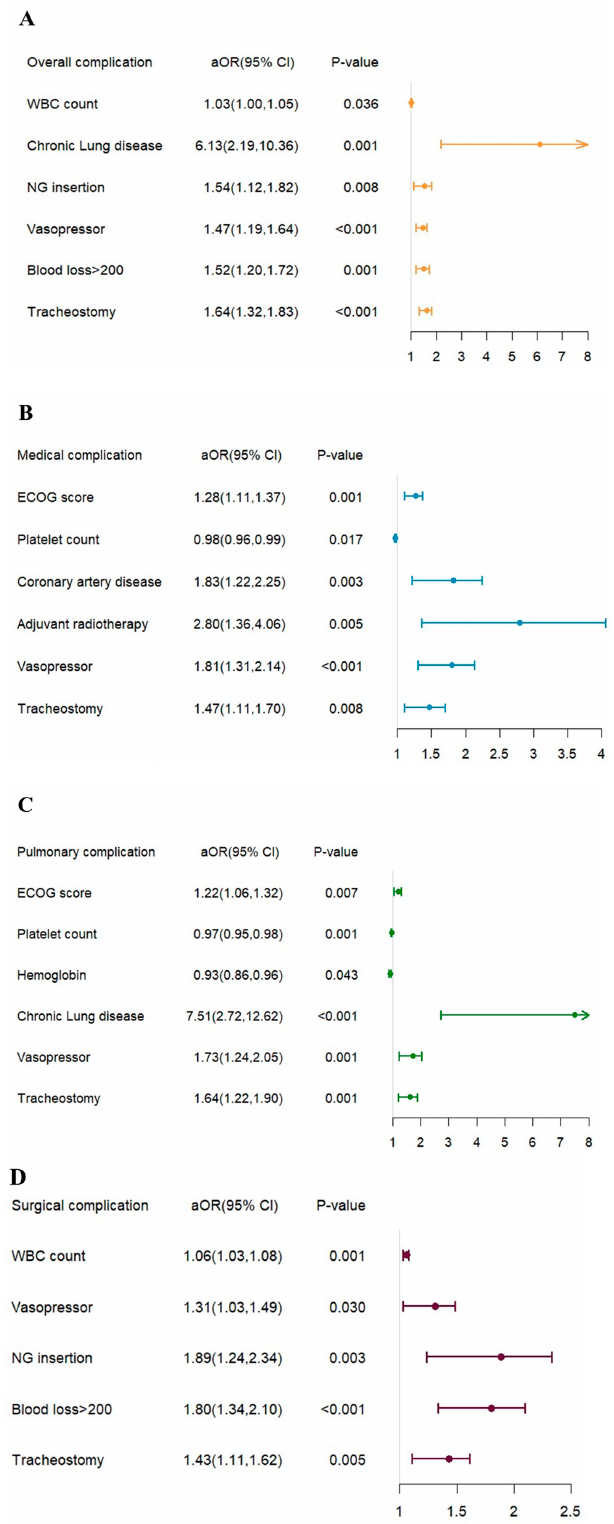
Figure 3. The significant risk factor for ( A ) overall complication, ( B ) medical complication, ( C ) pul- monary complication, and ( D ) surgical complication. Higher ECOG score (OR = 1.28, [95% CI] = 1.11–1.37; p -value = 0.001), comorbidity with coronary artery disease (OR = 1.83, [95% CI] = 1.22–2.25; p -value = 0.003), the patients who received adjuvant radiotherapy (OR = 2.80, [95% CI] = 1.36–4.06; p -value = 0.005), the patients who ever received vasopressors (OR = 1.81, [95% CI] = 1.31–2.14; p -value < 0.001) and the patients who received tracheostomy during surgery (OR =1.47, [95% CI] = 1.11– 1.70; p -value = 0.008) were shown to have a higher risk for medical complications. Higher pre-operative PLT levels (OR =0.98, [95% CI] = 0.96–0.99; p -value = 0.017) had a lower risk of medical complications. Higher ECOG scores (OR = 1.22, [95% CI] = 1.06–1.32; p -value = 0.007), comorbidity with chronic lung disease (OR = 7.51, [95% CI] = 2.72–12.62; p -value < 0.001), patients who ever received vasopressors (OR = 1.73, [95% CI] = 1.24–2.05; p -value = 0.001) and the patients who received tracheostomy during surgery (OR =1.64, [95% CI] = 1.22–1.90; p -value = 0.001) were shown to have higher risk for pulmonary complications. Higher pre-operative Hb lev- els (OR = 0.93, [95% CI] = 0.86–0.96; p -value = 0.043) and PLT levels (OR = 0.97, [95% CI] = 0.95–0.98; p -value = 0.001) were shown to have a lower risk of pulmonary complications. Higher WBC counts (OR = 1.06, [95% CI] = 1.03–1.08; p -value = 0.001), patients who received vasopressors (OR = 1.31, [95% CI] = 1.03–1.49; p -value = 0.030), patients who re- ceived intra-operative NG insertion (OR =1.89, [95% CI] = 1.24–2.34; p -value = 0.003), the patients who had the amount of blood loss >200 c.c during surgery (OR =1.80, [95% CI] = 1.34–2.10; p -value < 0.001) and the patients who received tracheostomy during surgery (OR =1.43, [95% CI] = 1.11–1.62; p -value = 0.005) were shown to have higher risk for surgical com- plication. 3.3. Long-Term Outcome In the results of a Kaplan-Meier analysis, lower PNI was found to have lower overall survival compared with high PNI ( p < 0.001) (Figure 4B). The Cox’s proportional hazard models showed that the high PNI group had lower mortality risk in the unadjusted model (hazard ratio = 0.46, [95% CI] = 0.40–0.52, p -value < 0.001), multivariate model (hazard ratio = 0.73, [95% CI] = 0.63–0.85, p -value < 0.001), and propensity score matching model (hazard ratio = 0.79, [95% CI] = 0.66–0.94, p -value < 0.001) (Figure 4D). The overall recur- rence rate between the high and low PNI group was shown to be non-significant, but fewer recurrent events were noted within the first year of follow-up (Figure 4A). Higher PNI was significantly correlated with lower overall recurrent rate in an unadjusted model (hazard ratio = 0.79, [95% CI] = 0.69–0.91, p -value = 0.001), but was non-significant in a